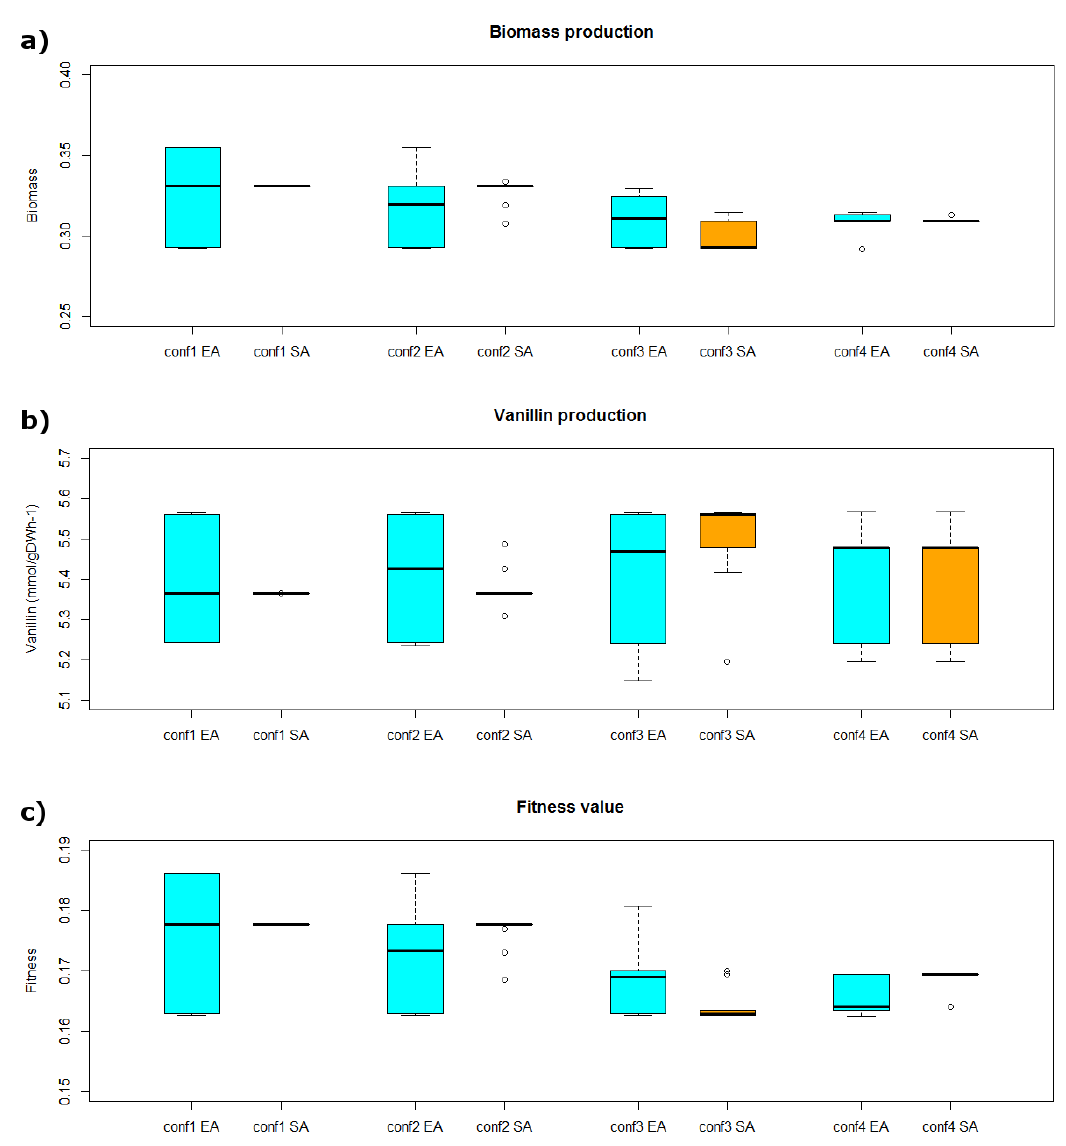
Figure 8: This figure shows the results obtained by the EA and SA algorithms in the 30 runs for each of the configurations showing boxplots for the: a) the values of biomass fluxes; b) the values for the desired product flux (vanillin production) and c) the fitness values